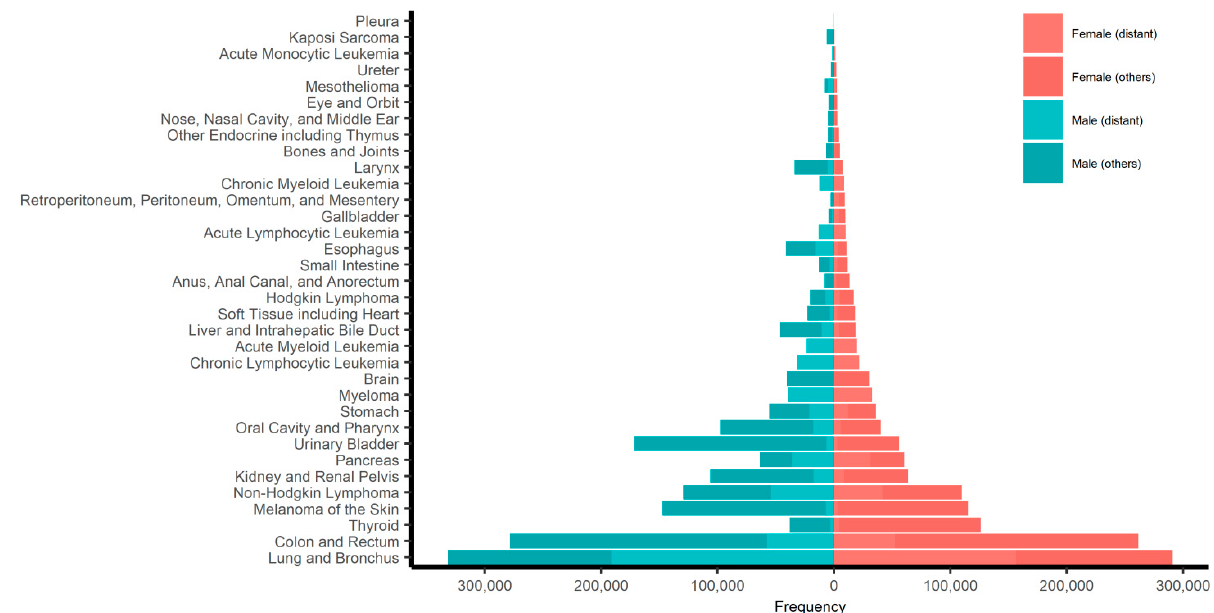
Figure 1. Pyramid plot of the site-specific frequencies of sex-nonspecific cancers stratified by sex. The frequencies of cancers with distant metastases (according to SEER historic stage A or SEER combined summary stage 2000) are indicated.